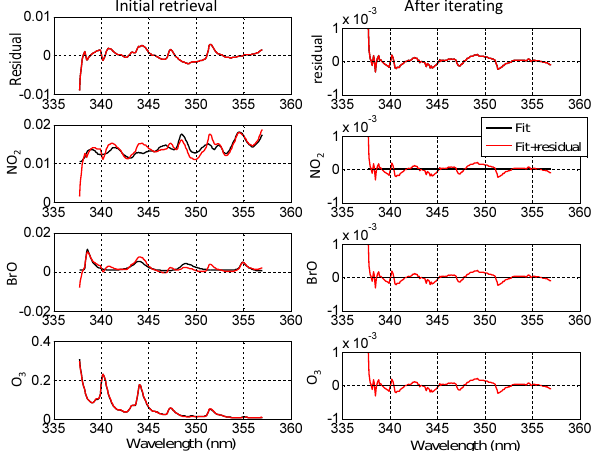
Figure 16. Same as Fig. 11 but for a standard DOAS fit, i.e. without considering the higher-order ozone absorption terms.